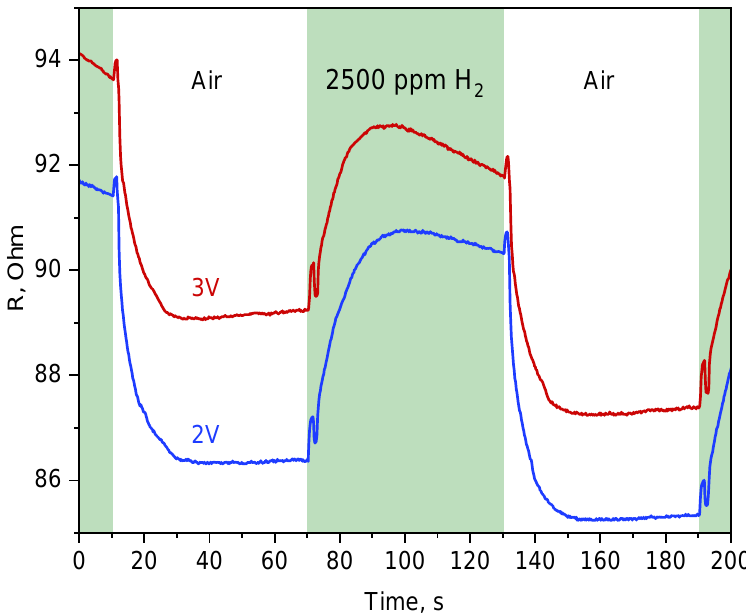
Figure 16. Resistance transients of a non-sintered microheater upon exposure to 2500 ppm of hydrogen mixed with air obtained at a voltage of 2 V (blue curve) and 3 V (red curve).